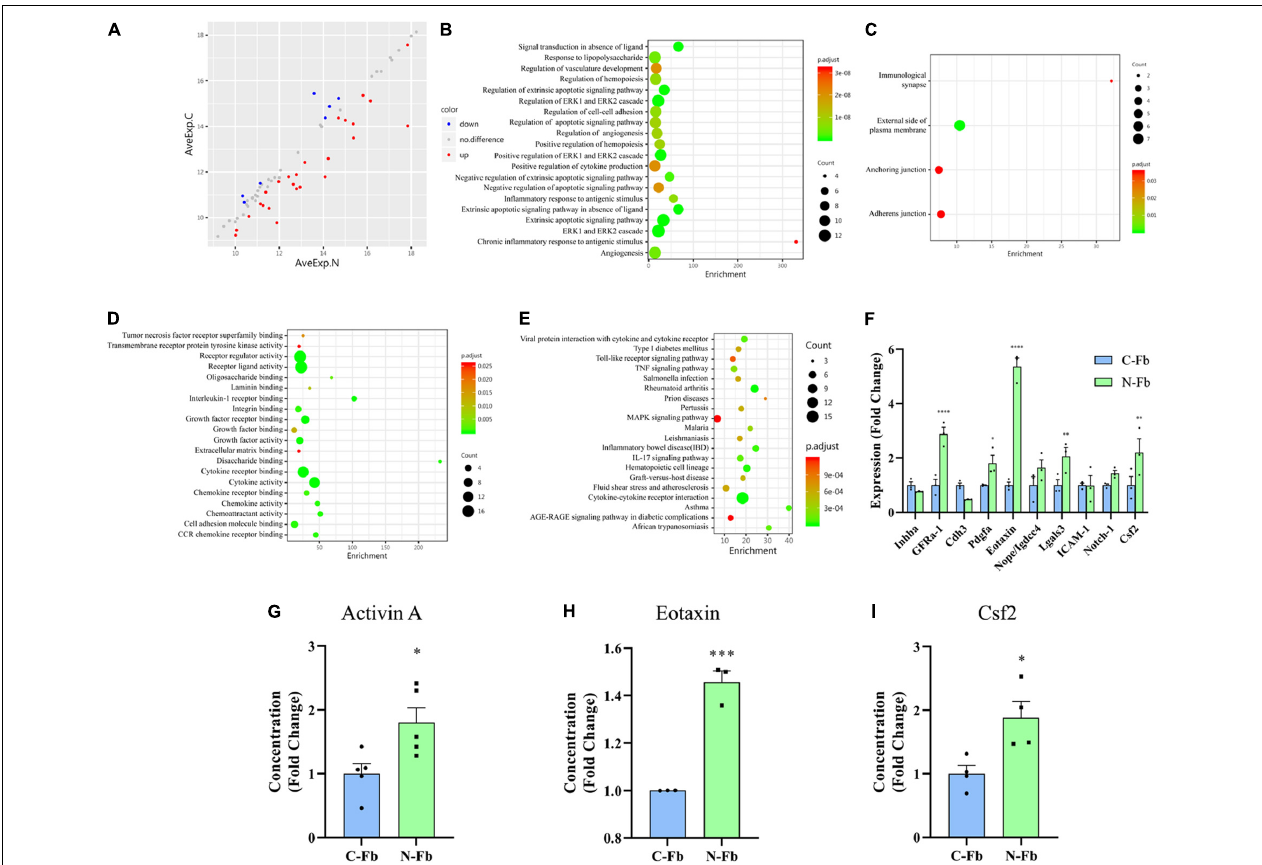
FIGURE 3 | Differentially expressed proteins in N-Fb CM vs. C-Fb CM. (A) Scatter plot of 32 differentially expressed proteins in N-Fb vs. C-Fb-conditioned medium with Log2-foldchange greater than 1.2 or less than 0.83. Red represents the upregulation, while blue represents the downregulation, and gray resembles no difference. Protein function annotation Gene Ontology (GO) and KEGG pathway were analyzed. GO analysis included three subtypes: (B) BP, (C) MF, and (D) CC. (E) KEGG pathway results reveal associated gene functions, linking genomic information with higher-order functional information. (F) q-PCR results of top ten differentially expressed proteins in N-Fb vs. C-Fb (three independent experiments). Statistical significance is indicated as ∗ p < 0.05, ∗∗ p < 0.01, ∗∗∗∗ p < 0.0001 (unpaired Student’s t -test). ELISA results of activin A (G) (five independent experiments), Eotaxin (H) (three independent experiments), and Csf2 (I) (four independent experiments). Statistical significance is indicated as ∗ p < 0.05, ∗∗∗ p < 0.001 (unpaired Student’s t